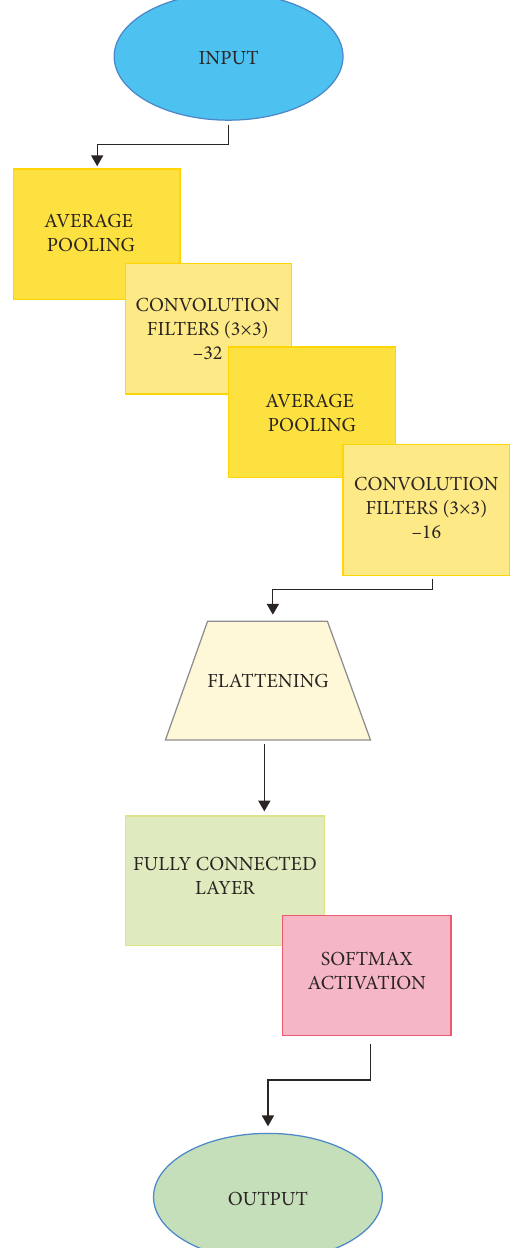
Figure 13: CNN architecture [57].